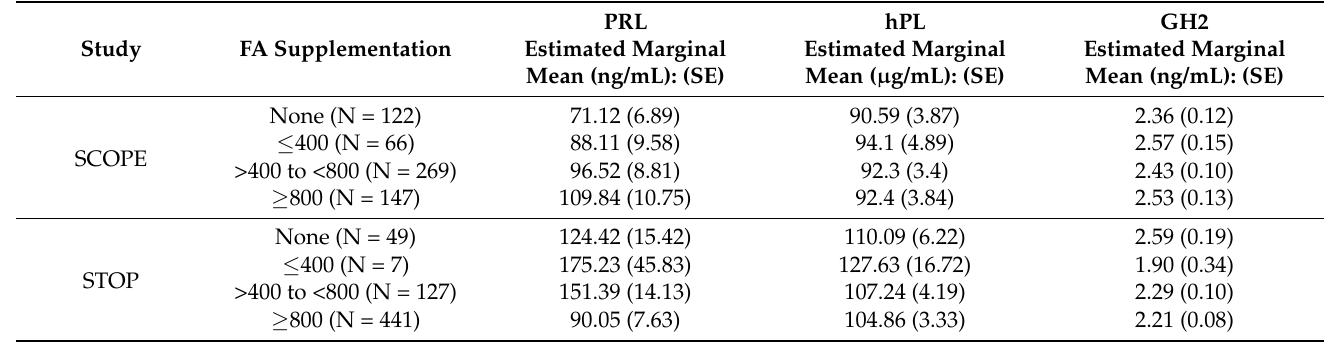
Table 3. Serum hormone concentrations in SCOPE (14–16 weeks of gestation) and STOP (6–16 weeks) women with uncomplicated pregnancies stratified by FA supplementation